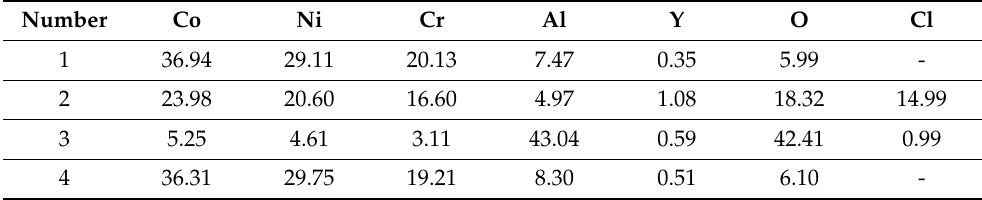
Figure 6. Surface morphologies of these corroded coatings: ( a , b ) CoNiCrAlY coating; ( c , d ) CoNiCrAlY-Al 2 O 3 coating. CoNiCrAlY-Al 2 O 3 coating. Table 8. EDS analysis results of the positions as marked in Figure 6 (at.%). Table 8. EDS analysis results of the positions as marked in Figure 6